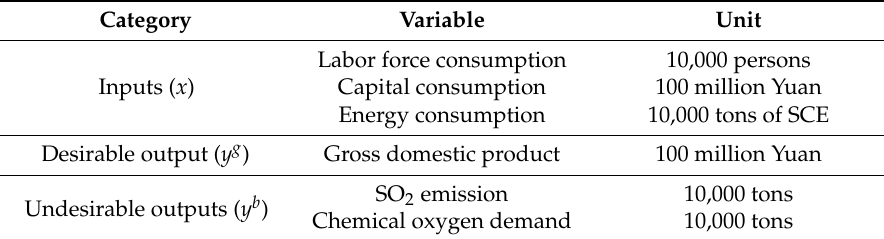
Table 2. Indicators for evaluating total factor energy efficiency